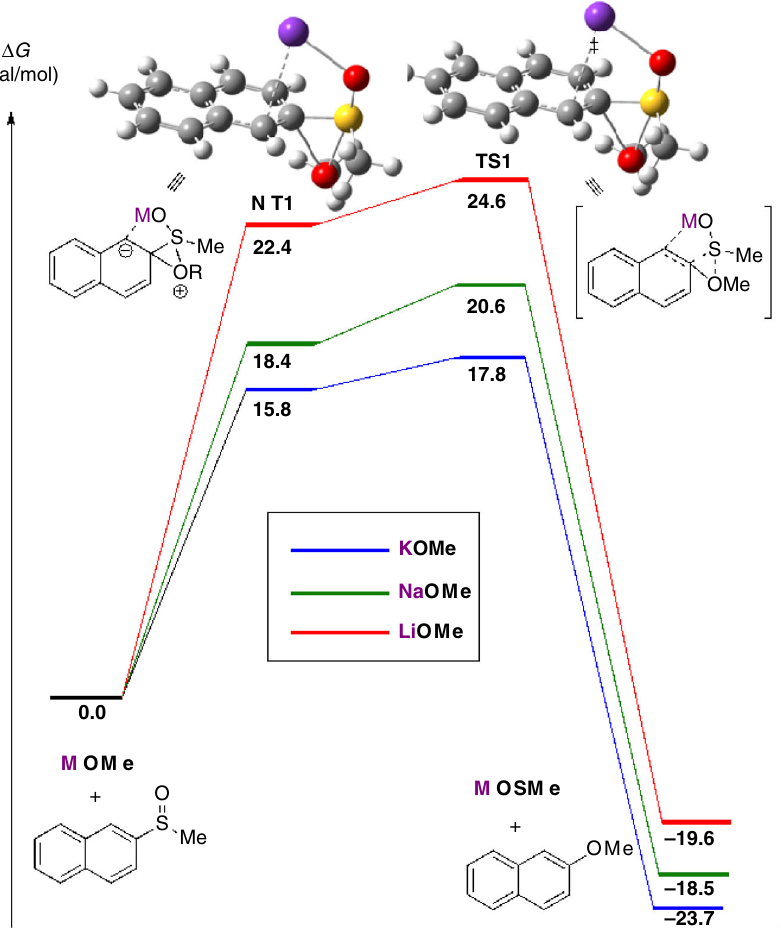
Fig. 6 Free energy pro fi le for the reaction of 1a with methoxide in presence of different counterions (M = Li, Na and K). Relative free energy values were calculated with SMD-1,4-dioxane-M06-2×/6-31 + G(d,p)// B3LYP/6-31 +